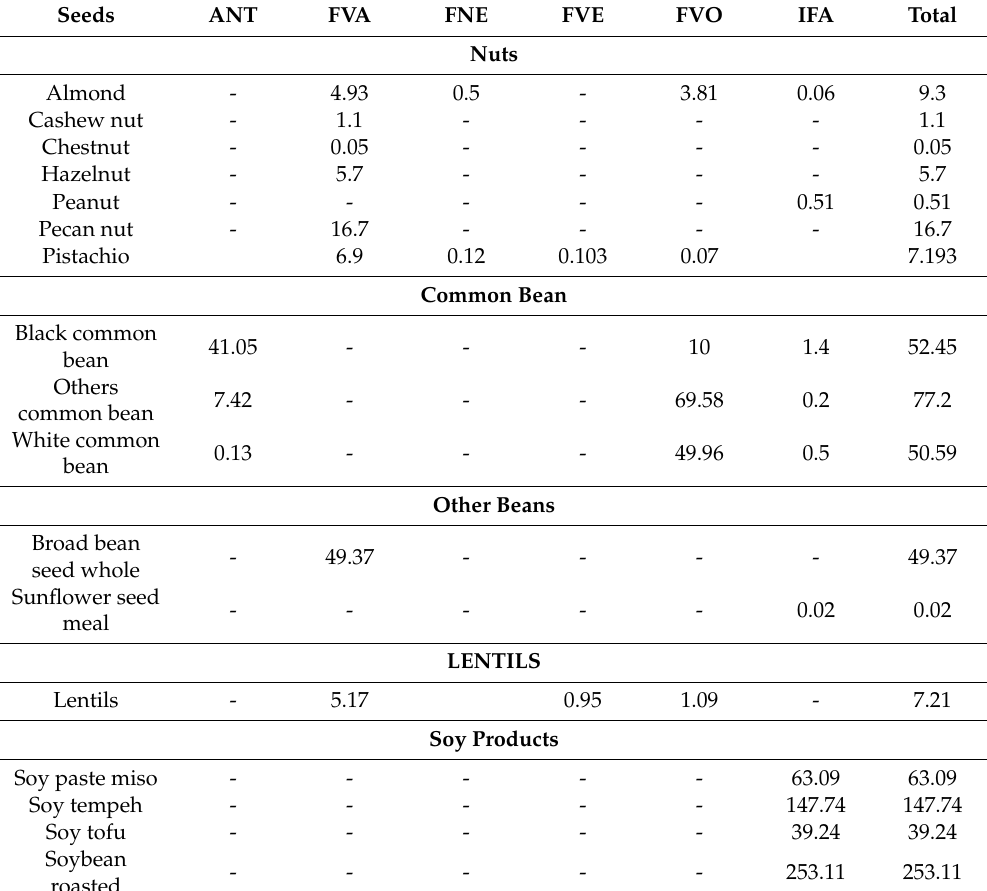
Table 3. Flavonoid contents of seeds (mg / 100 g food) [24].